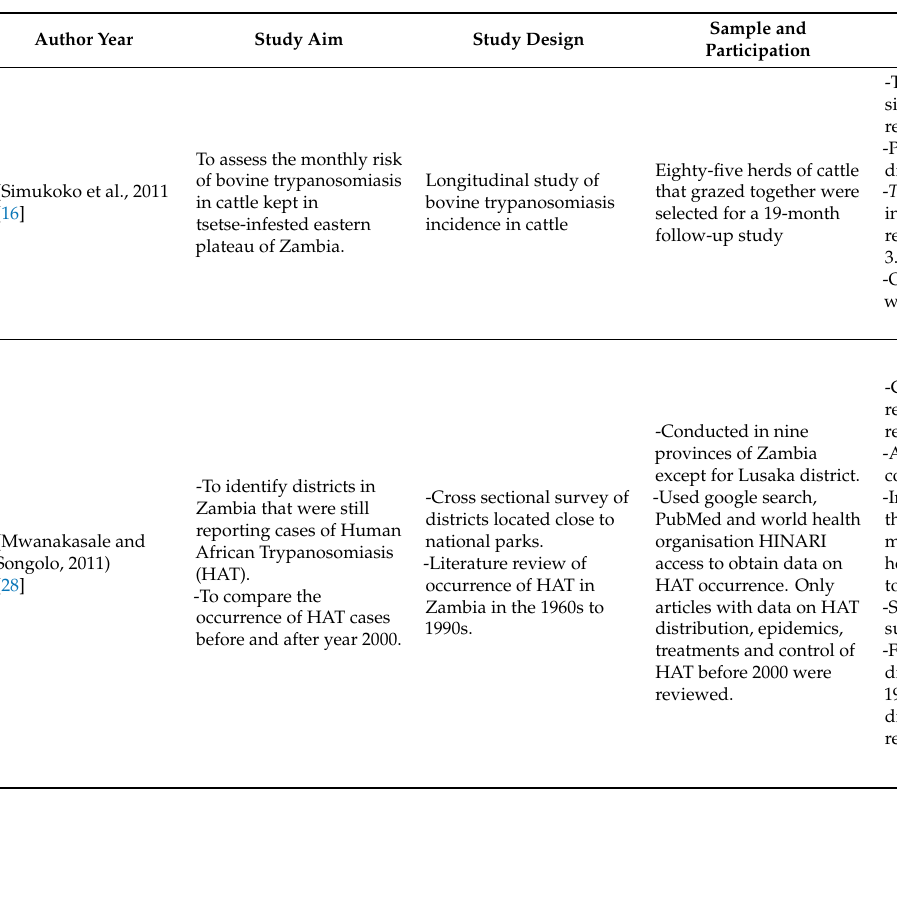
Table A1. Articles meeting selection criteria on trypanosomiasis control in Zambia between January 2009 and December 2019 and a summary of key